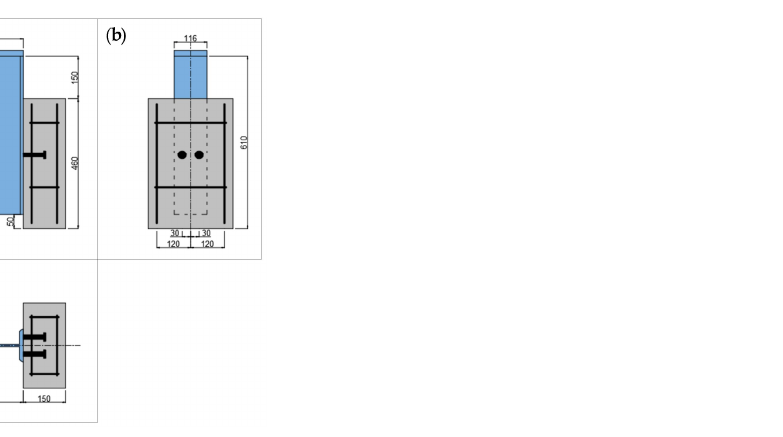
Figure 1. Detailed size of push-out specimen (unit: mm): ( a ) main view; ( b ) left view; ( c ) top view.